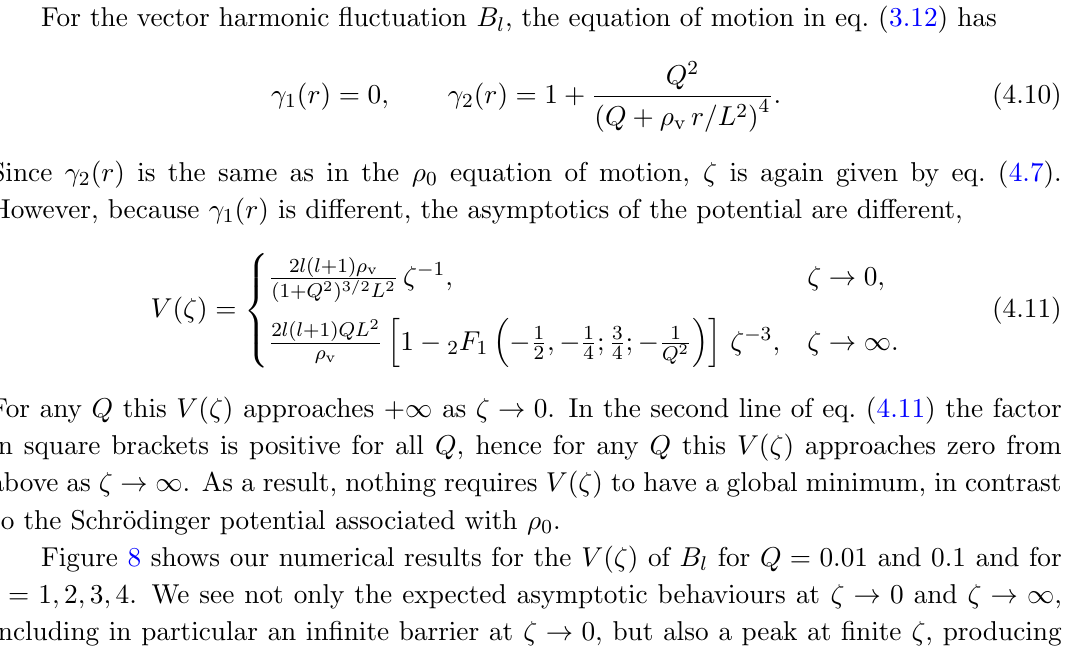
Figure 8. The Schr(cid:127)odinger potential V ( (cid:16) ) de(cid:12)ned in eq. (4.5), in units of (cid:26) 2 (cid:16) , in units of L 2 =(cid:26) v , for the (cid:13)uctuation B l with (a) Q = 0 : 01 and (b) Q = 0 : 1 and l = 1 ; 2 ; 3 ; 4 (black dot-dashed, red dotted, orange dashed, solid blue,